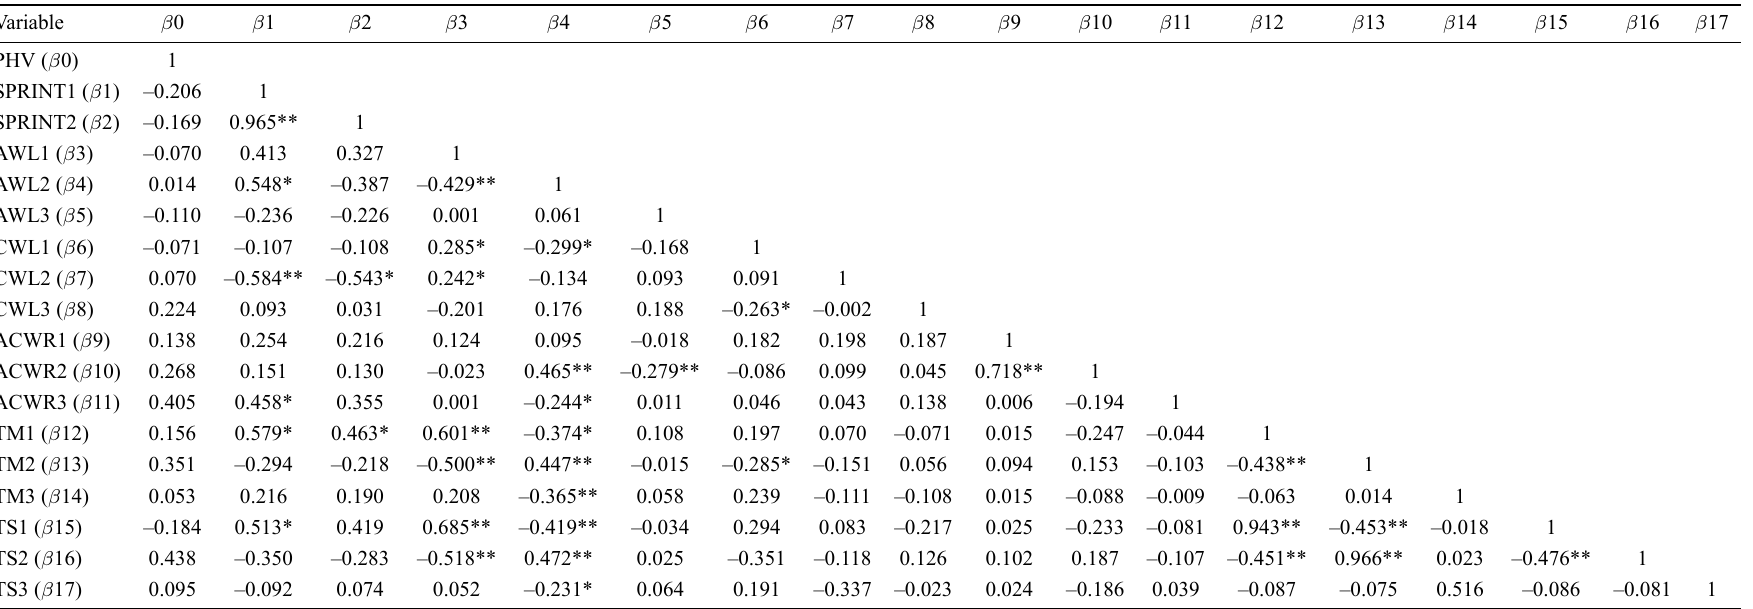
Table 1. Pearson and Spearman correlation analysis between the workload parameters and sprint